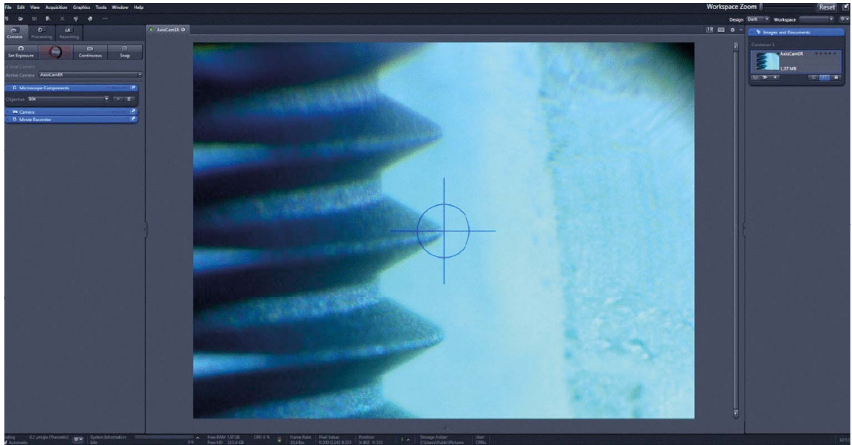
Figure 1. Optical Microscope obtained image, and vortex marking to the distance